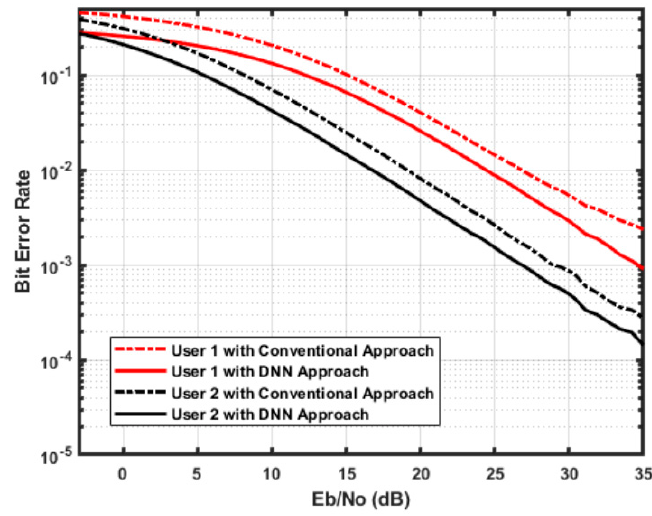
Figure 5. Performance of NOMA user pair through DNN-based technique [89].